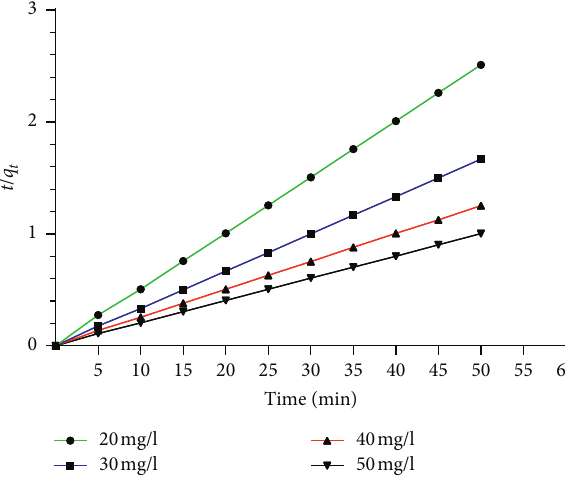
Figure 8: Pseudo-second-order kinetic model for the adsorption of BG onto ASP. Table 3: Adsorption of BG dye onto ASP: kinetic model parameters of intraparticle diffusion, pseudo-first-order, and pseudo-second-order